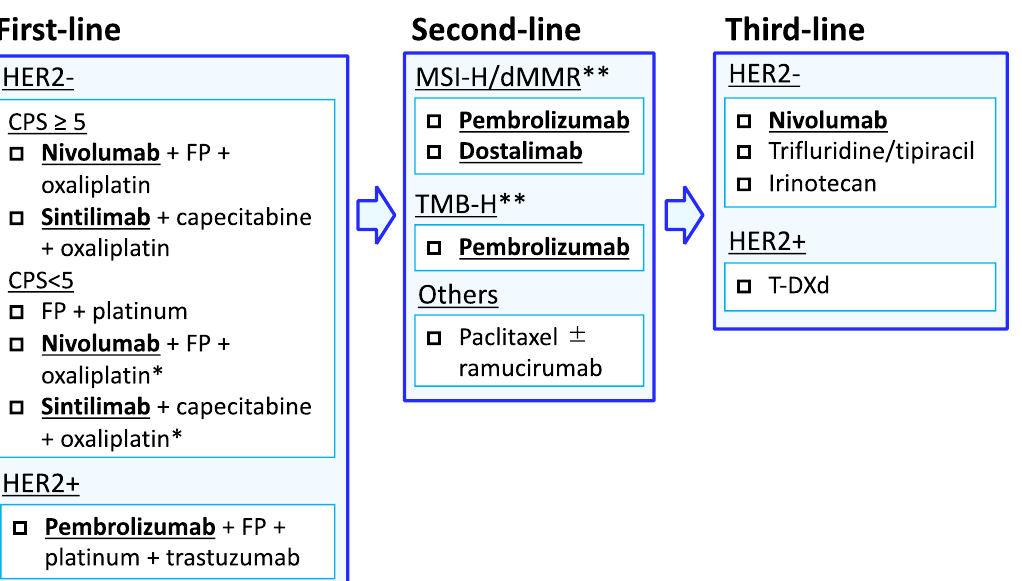
Figure 3. Treatment algorithm for advanced gastric cancer. The management of patients with ad- vanced gastric cancer is primarily based on PD-L1 CPS and HER2 status. * Combination of nivolumab or sintilimab with chemotherapy may depend on a patient’s general condition, personal or institu- tional experience, approval status, adverse events, cost-effectiveness, and accessibility to subsequent immunotherapy for chemotherapy-naïve advanced gastric cancer patients with CPS < 5 tumors. ** Paclitaxel plus ramucirumab also is a standard regimen for MSI-H or TMB-H gastric cancer. Ab- breviation: FP, fluoropyrimidine; MSI-H, microsatellite instability high; dMMR, mismatch repair deficient; HER2, human epidermal growth factor receptor 2; CPS, combined positivity score; T-DXd, trastuzumab